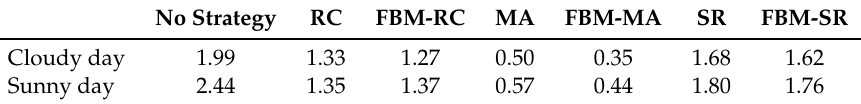
Table 5. Ramps’ mean values for each strategy in both cases.